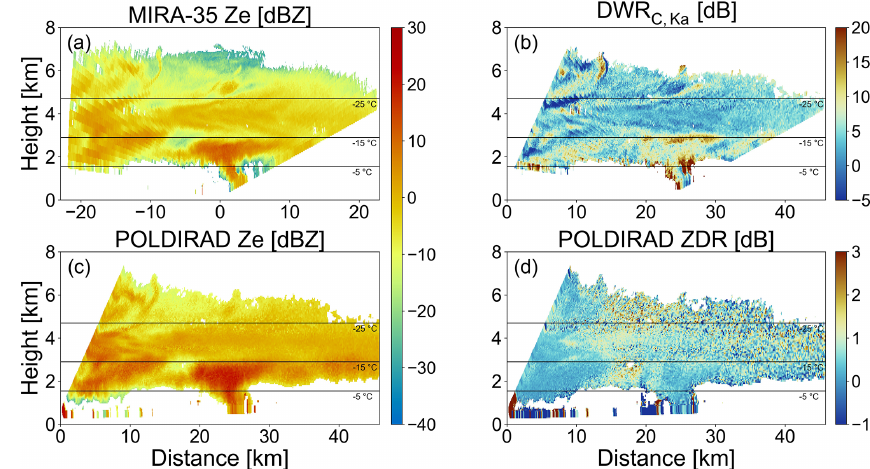
Figure 3. Radar observations of (a, c) MIRA-35 and POLDIRAD Z e , (b) DWR, and (d) POLDIRAD ZDR from 30 January 2019 at 10:08UTC. The − 5, − 15, and − 25 ◦ C temperature levels are plotted with black solid lines (source: Deutscher Wetterdienst, data provided by University of Wyoming; http://weather.uwyo.edu/upperair/sounding.html, last access: 8 April 2022).